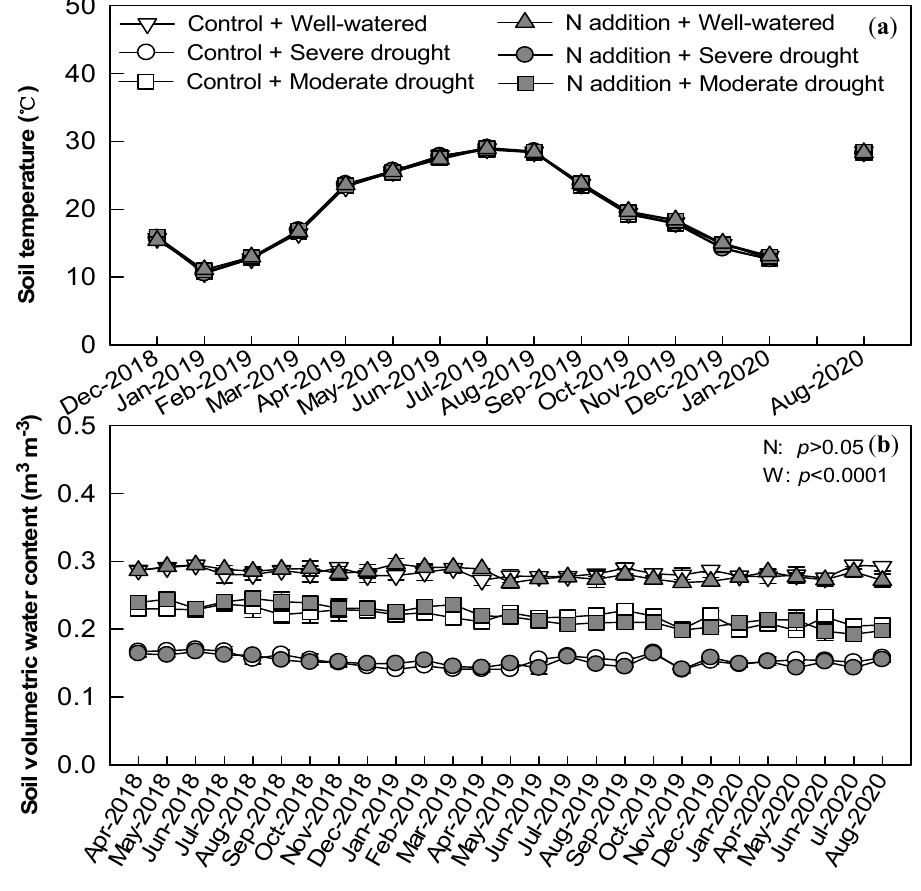
Figure 1. Soil temperature ( a ) and soil volumetric water content ( b ) in the different treatments. N addition, drought, and their interaction affected ( p < 0.05) soil pH, NO − 3 -N, and NH + 4 -N concentrations (Table 1). Overall, N addition decreased soil pH ( p < 0.001) and AP concentrations ( p < 0.01) and increased total N ( p < 0.05), NO − 3 -N ( p < 0.001), and NH + 4 -N concentrations ( p < 0.05). Drought decreased soil pH ( p < 0.001) and increased NO − 3 -N ( p < 0.01) and NH + 4 -N concentrations ( p < 0.05). In the well-watered and moderate